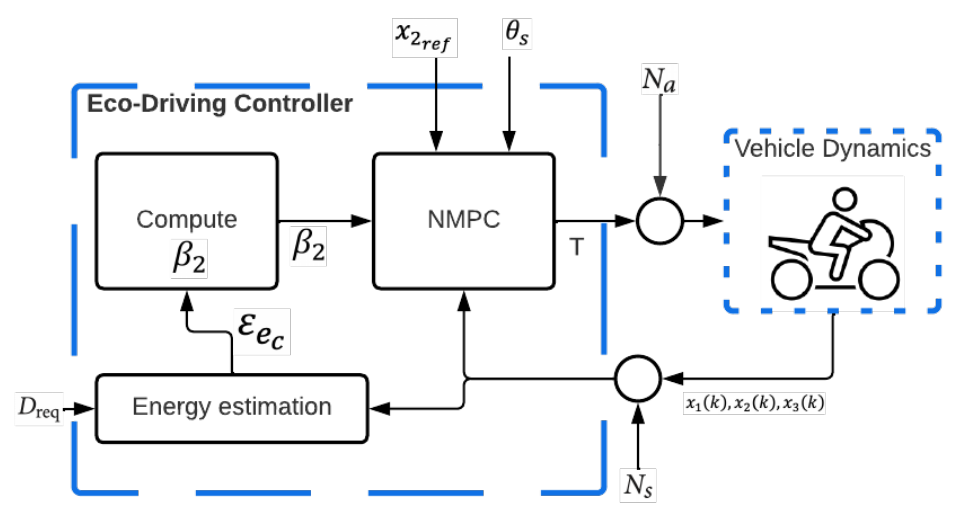
Figure 3. Control